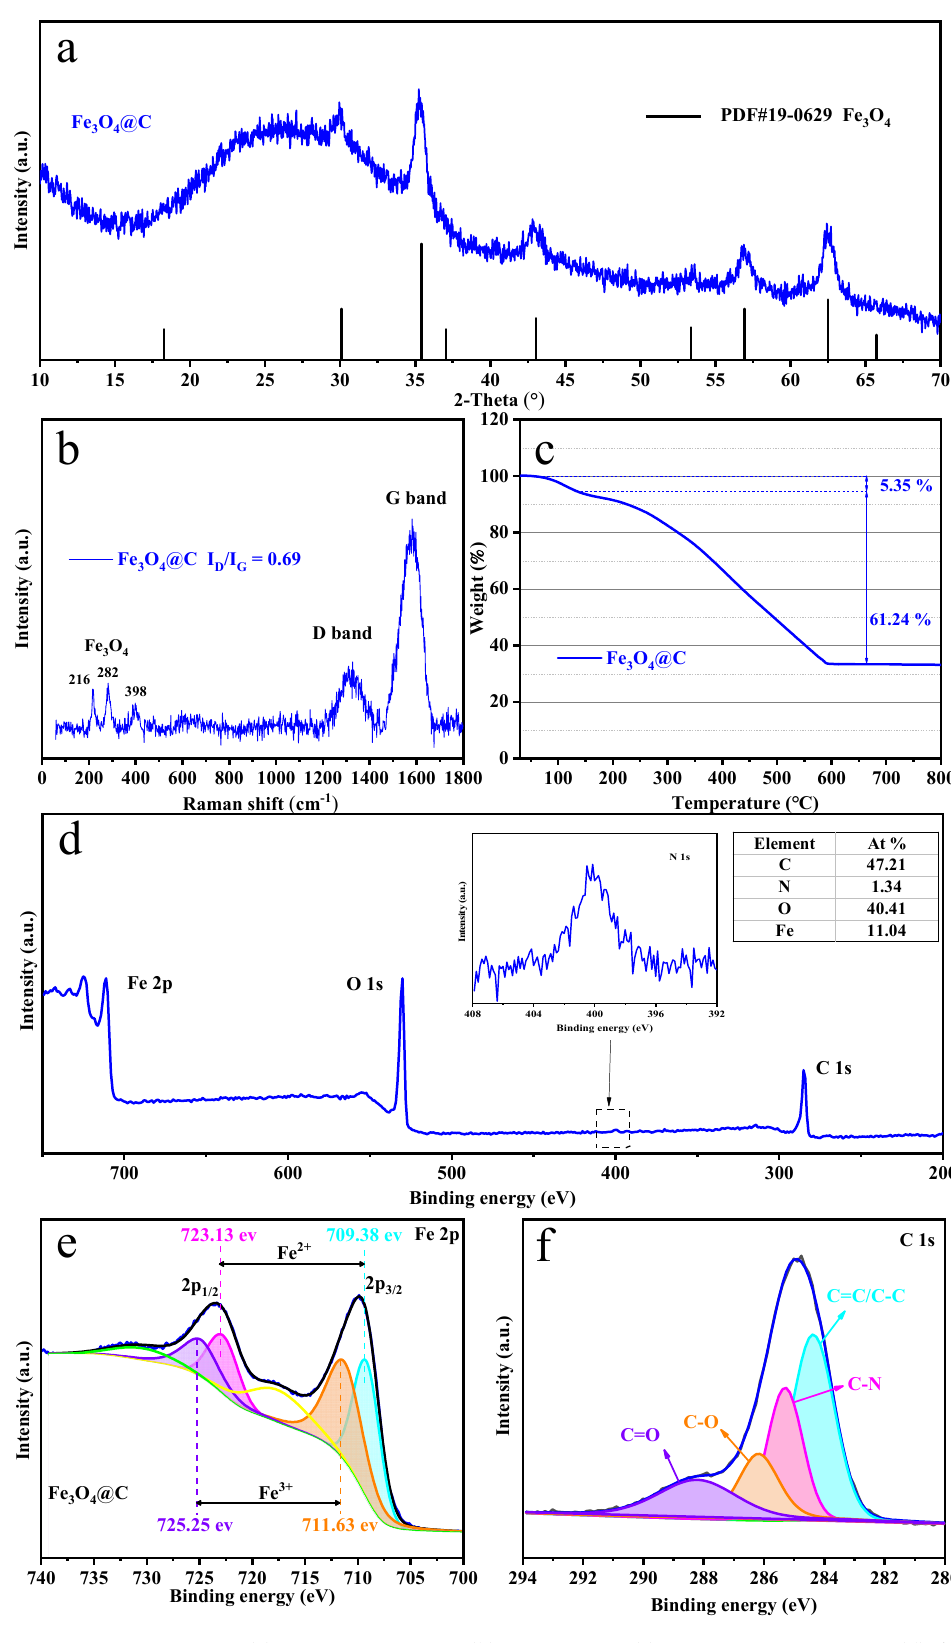
Figure 1. XRD pattern ( a ), Raman spectrum ( b ), TGA curve ( c ), survey XPS spectrum ( d ), high- resolution Fe 2p ( e ) and C 1s ( f ) XPS spectra of the Fe 3 O 4 @C sample. Figure 2a shows the overall FESEM image of the Fe 3 O 4 @C composite, and it can be seen that the submicron sized spherical structures are without obvious structural damage.